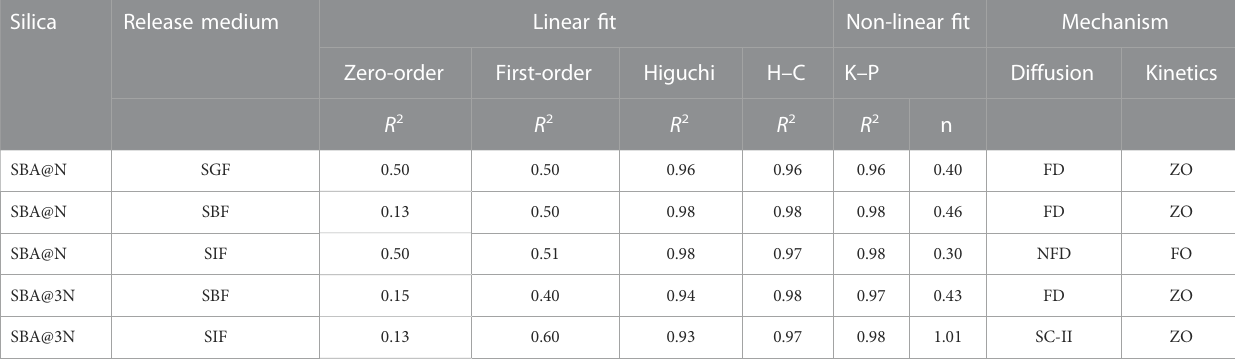
TABLE 3 Mathematical modeling of zero-order and fi rst-order models to the drug release data up to 24 h and of Higuchi model, Hixson – Crowell (H – C), and Korsmeyer – Peppas (K – P) up to 6 h in simulated gastric fl uid (SGF), body fl uid (SGF), and intestinal fl uid (SIF). The correlation coef fi cient ( R 2 ), diffusion exponent ( n ), Fickian diffusion (FD), and zero-order